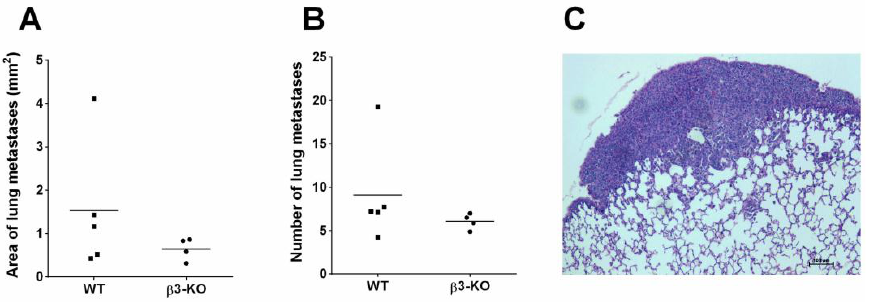
Figure 9. Histomorphometric quantification of H & E-stained lungs from the 4T1 model in WT ( n = 5) and β3-KO ( n = 4) mice. Average area per lung covered by metastases ( A ) and average number of metastases per lung ( B ) is shown. No statistical differences were found ( p = 0.41, p = 0.19). A representative lung metastasis from a WT mouse is shown ( C ). Scale bar indicates 100 µm.